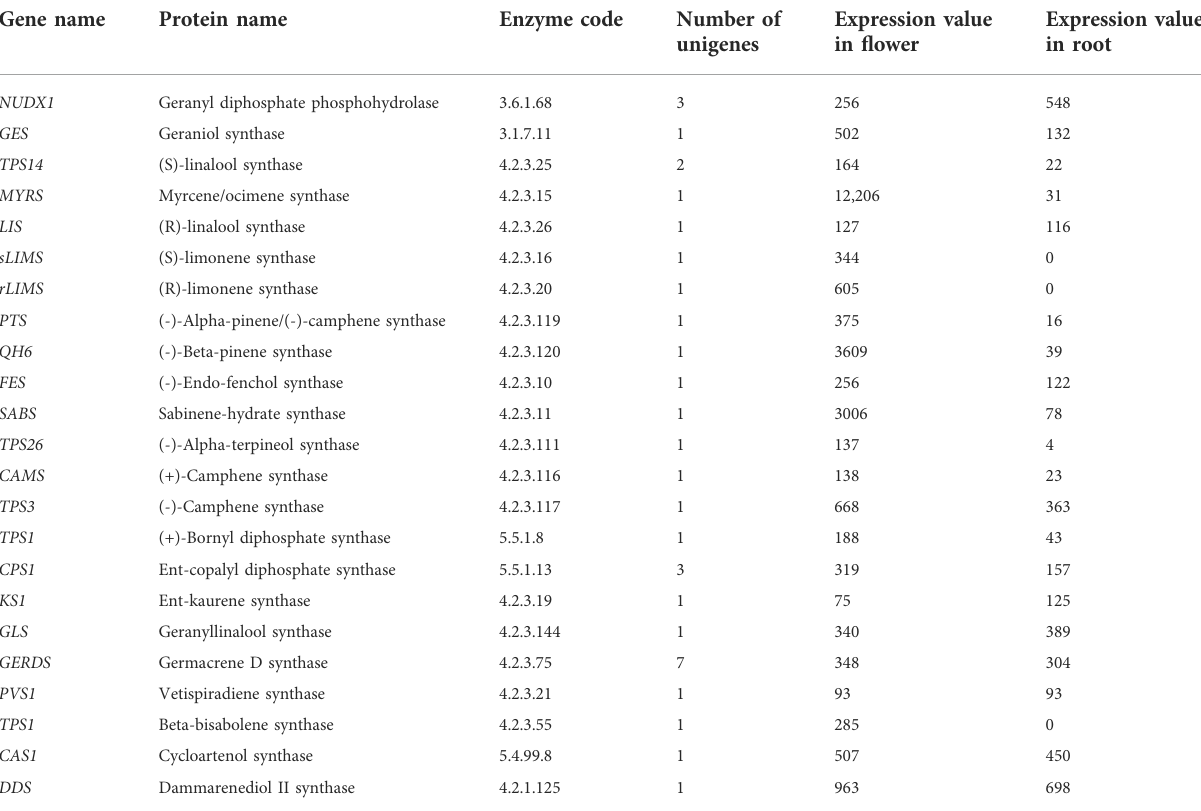
TABLE 7 List of key genes involved in mono, di and triterpenoids biosynthesis pathway and their expression value in the fl ower and the root of the Oliveria decumbens